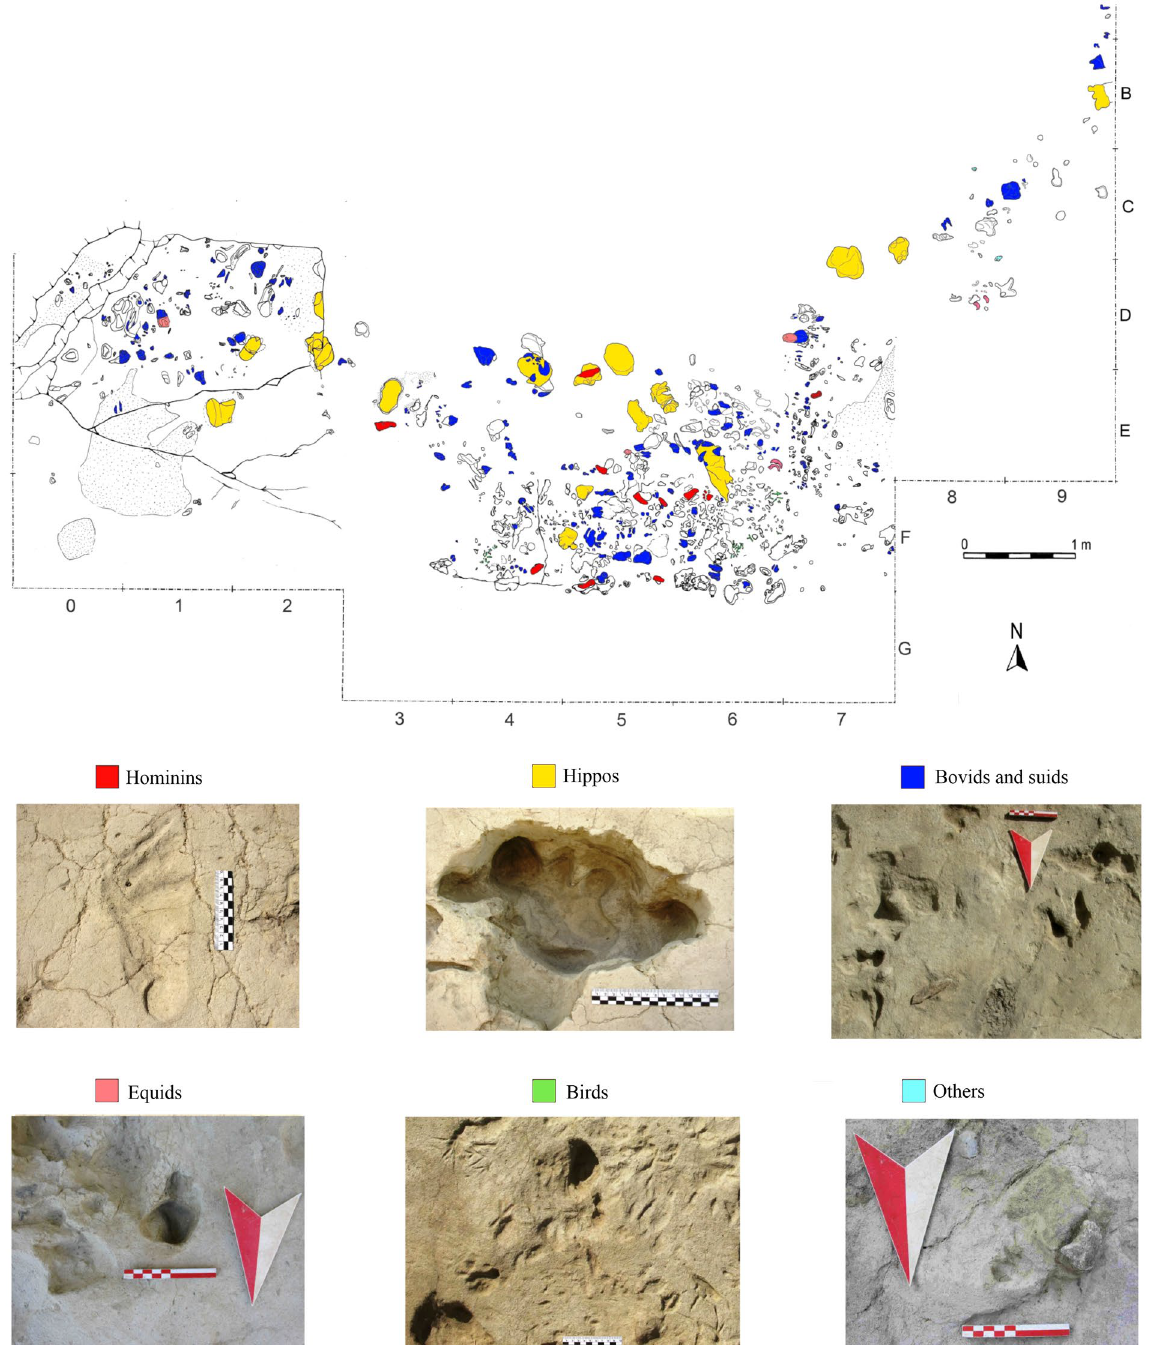
Figure 3. The ichnosurface of Gombore II-2. General planimetry of the excavated area (2013–2015) with colors referring to taxon attribution. Pictures of the best-preserved track(s) for each vertebrate group are provided: hominin (P-01, from square E3); hippo (sq. D2); bovid and possibly suid (sq. C8); equid (sq. E5); bird (sq. F6) and possibly a small carnivore (sq.